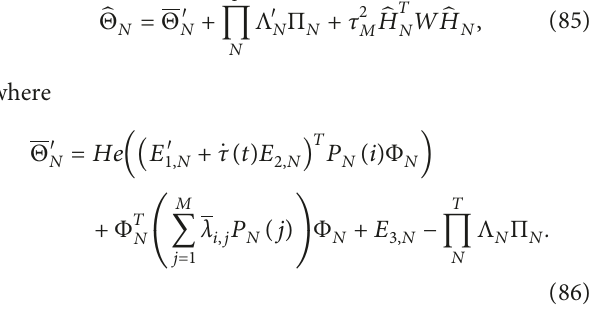
Figure 2. From Figure 2, σ k ( t ) changes from 0.01 to 0.3 and times. In addition, only 25 . 2% sampled signals are released.